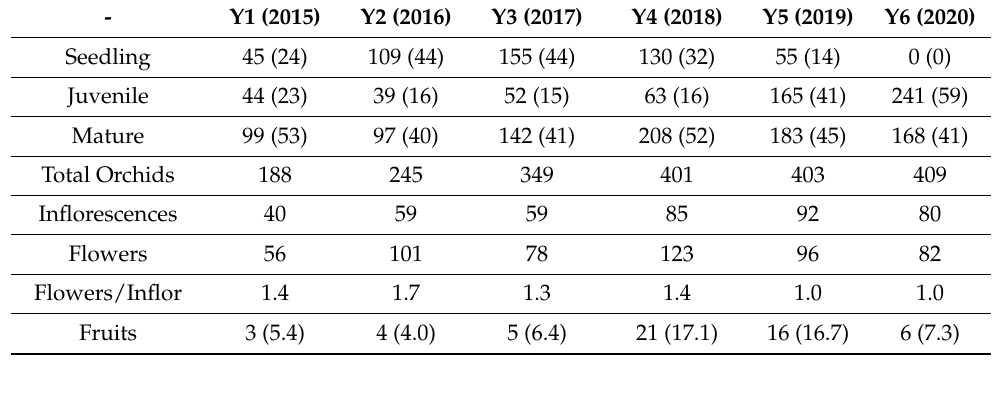
Table 1. The total number of Dendrophylax lindenii individuals present in the Florida Panther National Wildlife Refuge (FPNWR) in a given year for each of the six years (Y1-6, 2015–2020) listed by growth stage and fecundity for all seven populations pooled. Numbers in parentheses reflect the percentage of the total each year. Orchid numbers listed for each year reflect those that were recorded as living at the time of the survey. This number includes those documented the previous year as well as newly-discovered individuals and excludes individuals that perished since the last survey.